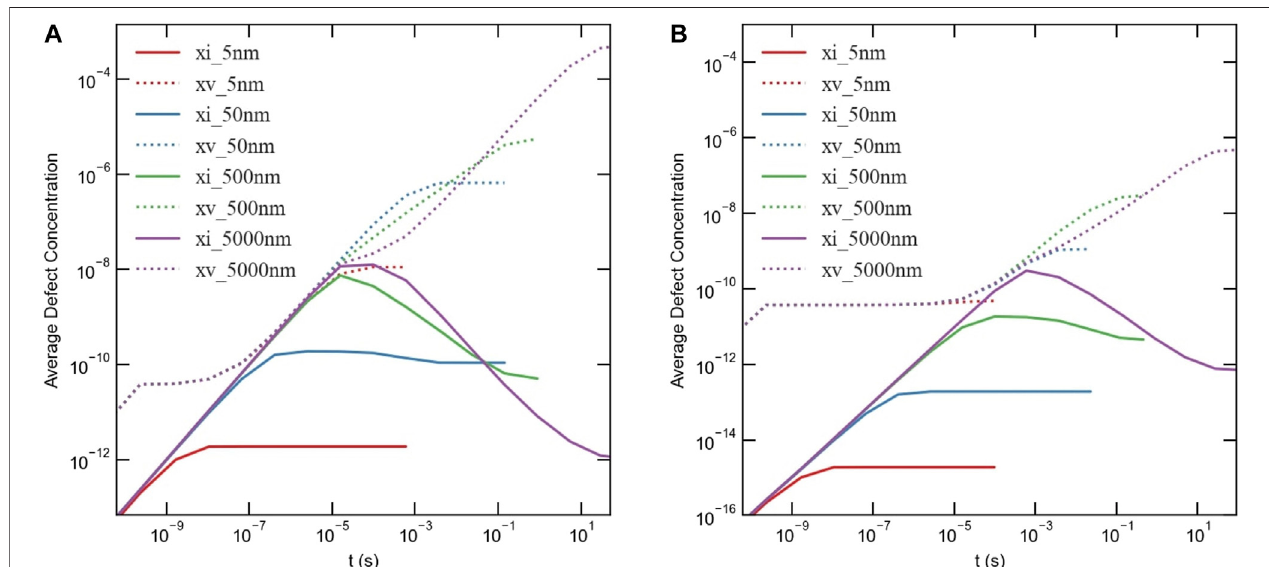
FIGURE2| Time-dependentbehavior ofaveragedefectconcentrationsfordifferentgrainsizeswitha5%production biasfor (A) 1e-6 dpa/s doserateand (B) 1e- 3 dpa/s dose rate. Two anomalies for the accumulation of point defects with grain size are observed. First, transient vacancy concentrations are higher in smaller grains during some time intervals, as reported in (Yang et al., 2010). Second, transient and steady-state interstitial concentrations decrease with grain size above a critical size (e.g., 1,000 nm for the low dose rate and 250 nm for the high dose rate). For the high dose rate, the average steady-state interstitial concentration at 5,000 nm is almost equal to its counterpart at 5 nm, while its corresponding vacancy concentration is, however, four orders of magnitude higher than its counterpart at 5 nm.